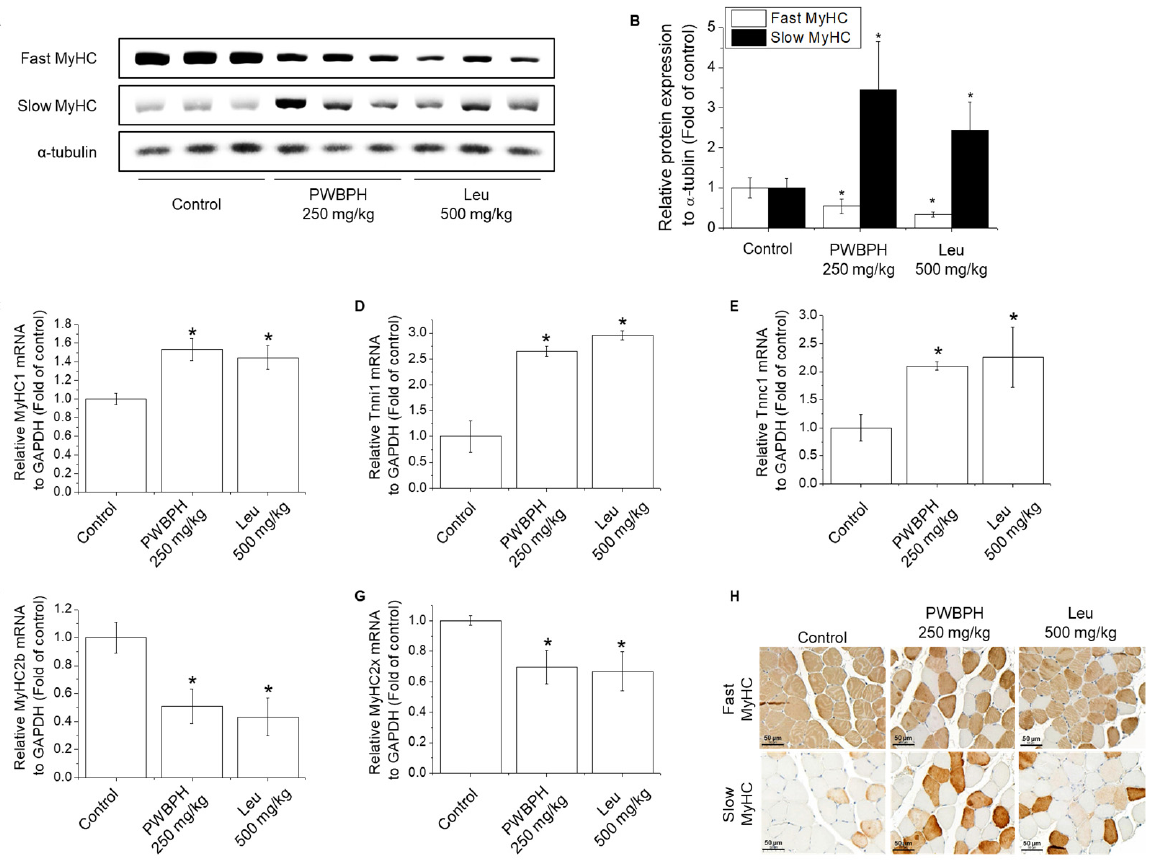
Figure 2. Effect of PWBPH on transformation from fast-twitch to slow-twitch muscle fiber type. ( A ) The protein levels of fast MyHC and slow MyHC in QF muscle of the control, PWBPH 250 mg/kg, and Leu 500 mg/kg groups were determined by Western blotting and ( B ) the band intensities were measured using ImageJ software. ( C – G ) qRT-PCR analysis of the mRNA levels of slow-twitch muscle fiber-related genes ( MyHC1 , Tnni1 , and Tnnc1 ) and fast-twitch muscle fiber-related genes ( MyHC2b and MyHC2x ). * p < 0.05 vs. control group. ( H ) Histological images of the QF muscle stained with slow-twitch and fast-twitch MyHC antibodies are shown (200× magnification).